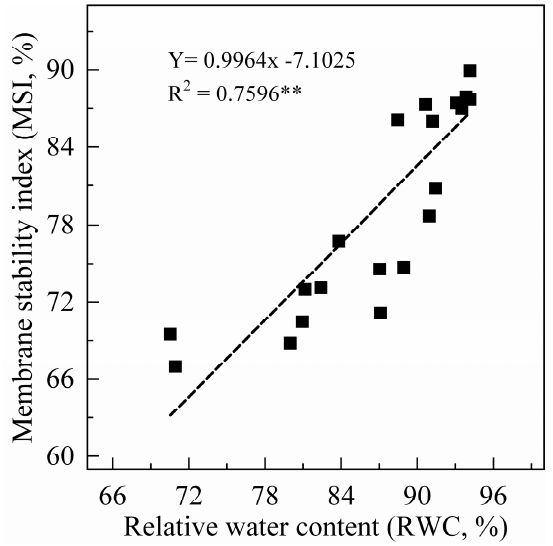
Figure 2. Correlation analysis between relative water content (RWC) and membrane stability index (MSI) in sweet potato leaves. n = 24, R 20.05 = 0.164, and R 20.01 = 0.265.